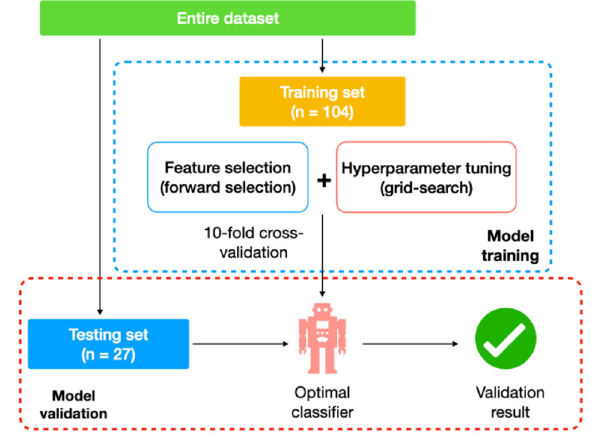
Fig. 4 Diagram of the proposed machine learning-based work- fl ow. The fl owchart describes the entire process of the developed machine learning-based data processing work fl ow, including all important factors of the data partition, feature selection, hyperpara- meter tuning, and model validation. The steps for model training and model validation are outlined in boxes with blue and red dashed lines,